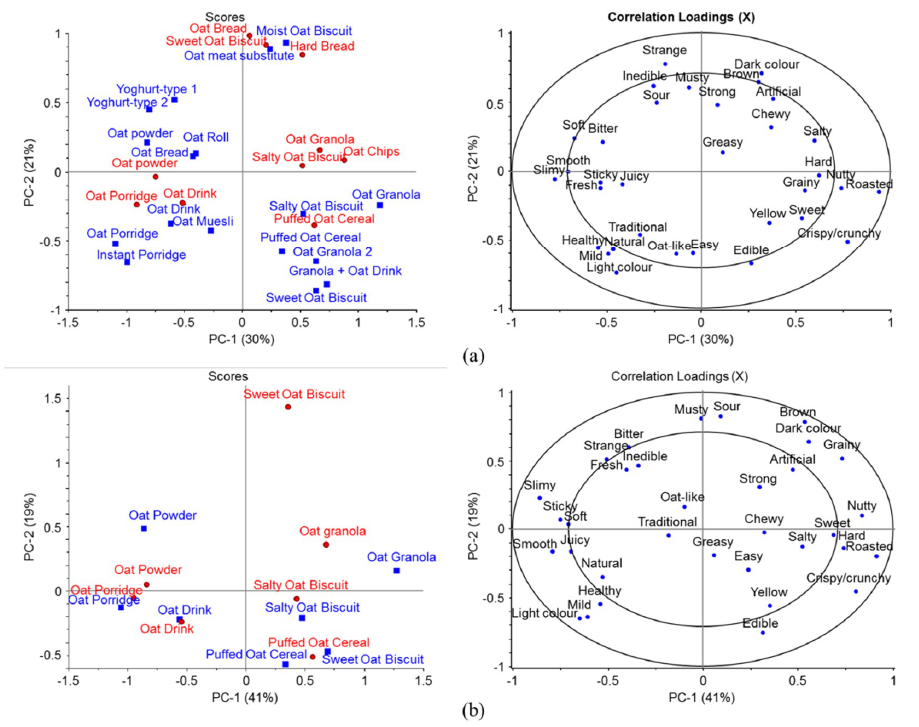
Figure 2. PCA models with ( a ) all samples included in the CATA tests in Finland (blue rectangles) and China (red circles) ( n = 27) with their sensory descriptors and ( b ) only seven samples included in both locations. Only attributes selected by a minimum of 5% of the panels were used in the models: